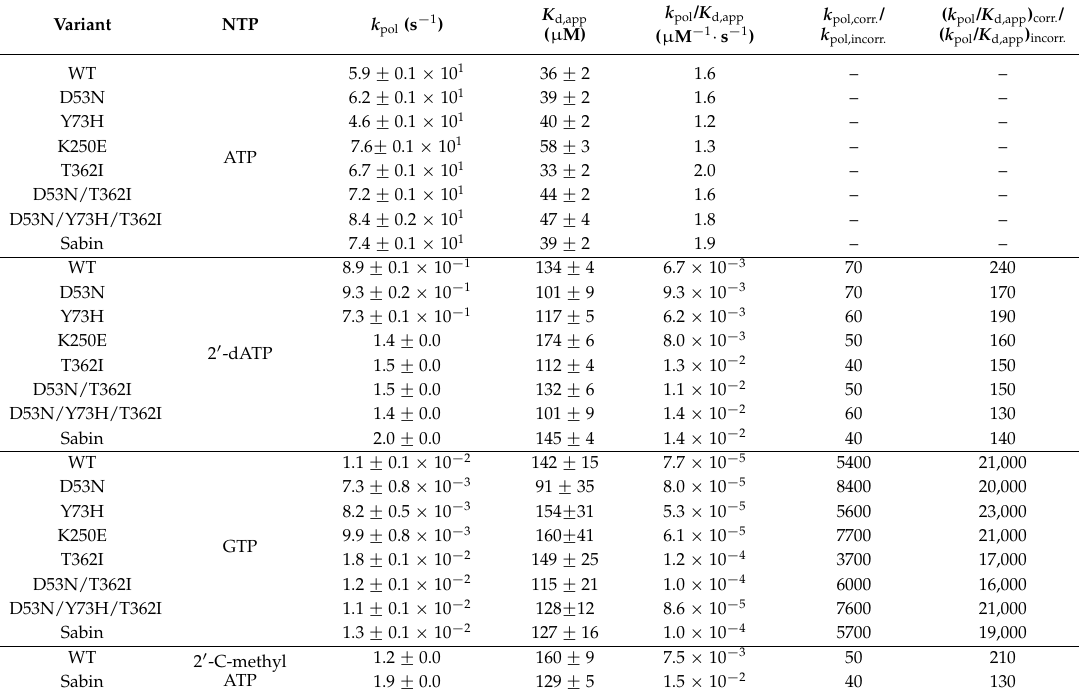
Table 1. The Sabin amino acid substitutions induce small changes in RdRp catalytic rates and fidelity.